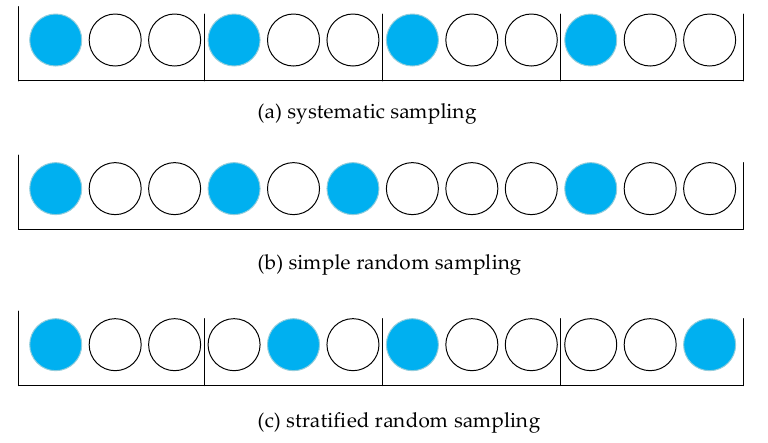
Figure 3. Three packet sampling methods. ( a ) Description of what is systematic sampling. ( b ) De- scription of what is simple random sampling. ( c ) Description of what is stratified random